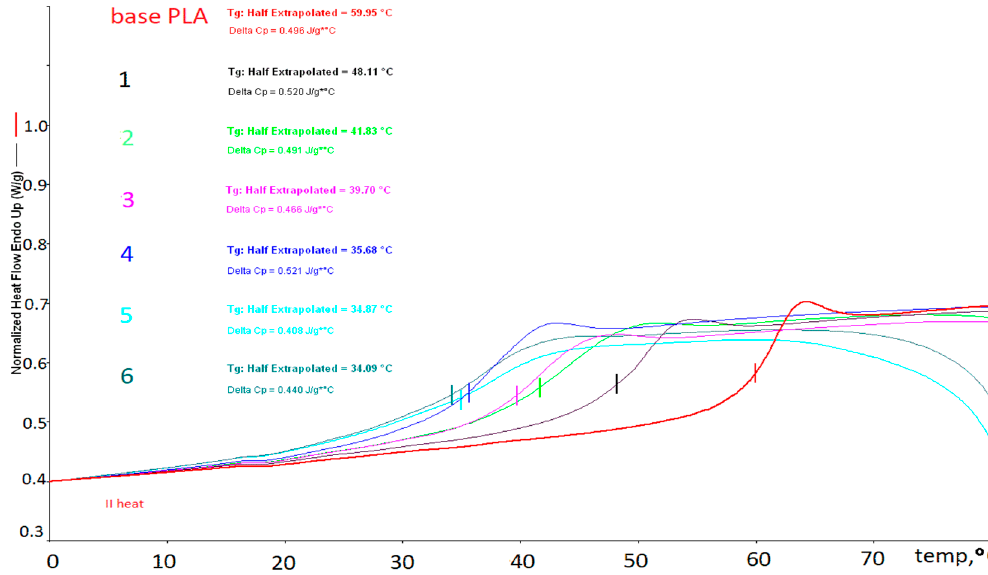
Figure 2. DSC curves from the second heat in the range of glass transition temperature.